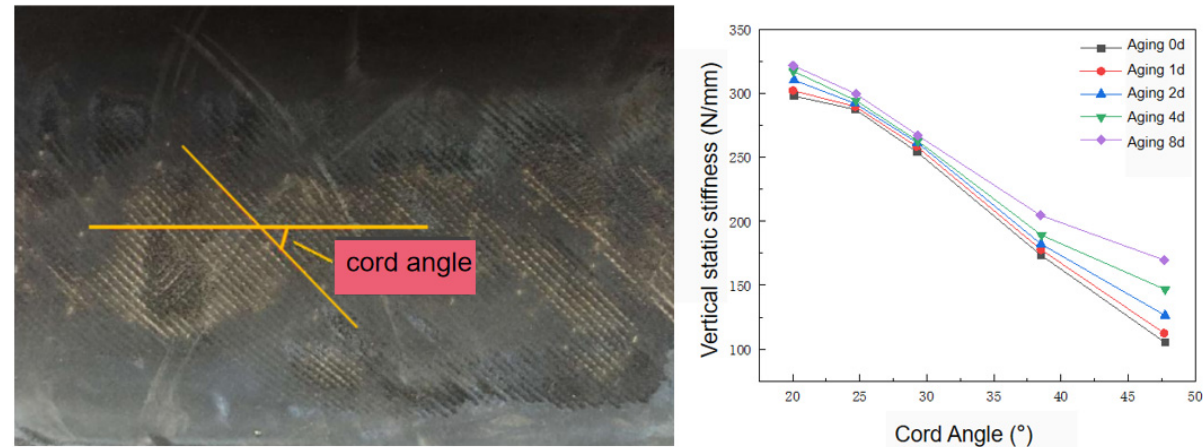
Figure 10. Vertical static stiffness of air spring with different cord angles during aging.